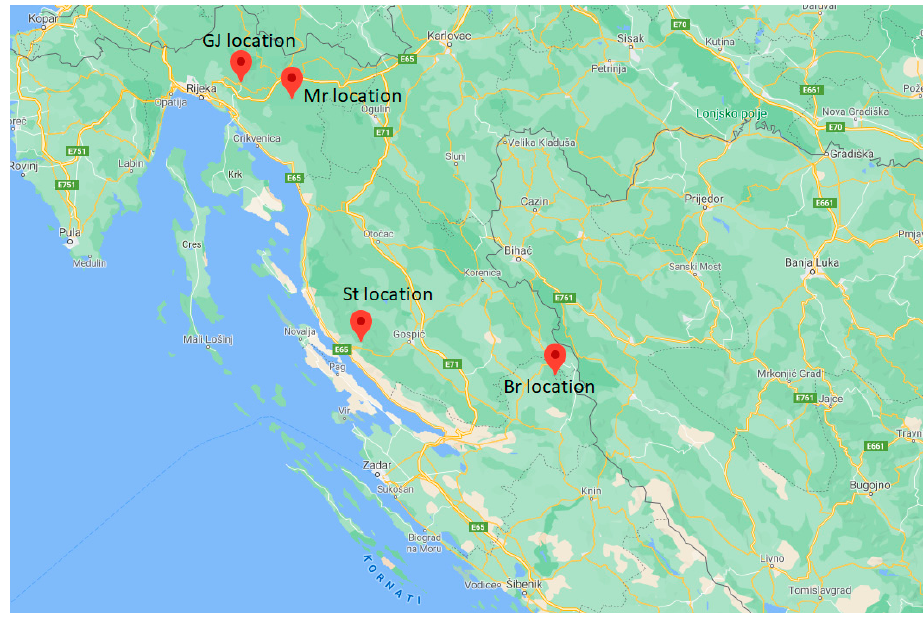
Figure 6. Map with the places of collection of the plant material.